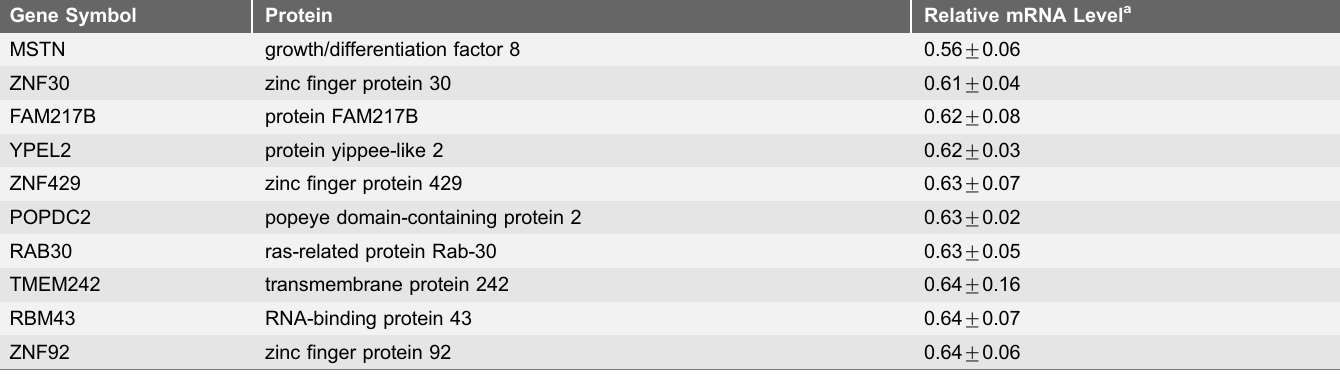
Table 3. Top 10 Repressed mRNA Gene Transcripts Following an Acute Dose of Electrical Muscle Stimulation. Gene Symbol